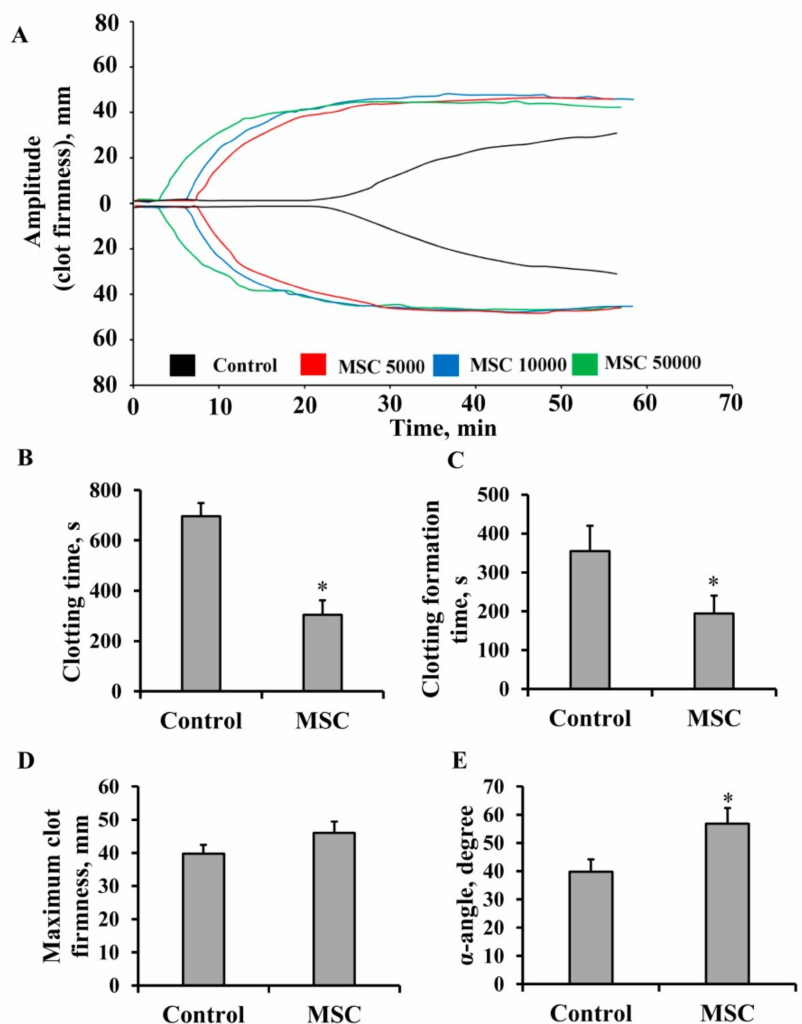
Figure 1. Procoagulant properties of mesenchymal stem cells (MSCs) against human blood. ( A ) Representative thromboelastometry diagram of dose-dependent effects of MSCs on blood coagulation. ( B ) Clotting time, ( C ) clot formation time, ( D ) maximum clot firmness, and ( E ) α -angle assayed by the nonactivated rotational thromboelastometric (NATEM) test. MSCs were resuspended in 1 mL of freshly obtained blood at concentrations of 5 × 10 3 , 1 × 10 4 , and 5 × 10 4 cells per mL for (A) and 5 × 10 4 cells per mL for (B–E), then 300 µ L of the suspension was sampled for analysis. Data reported as mean ± standard error. Blood from five donors was used, and each blood sample was incubated with MSCs obtained from three different umbilical cord samples. * p < 0.05, Student’s t